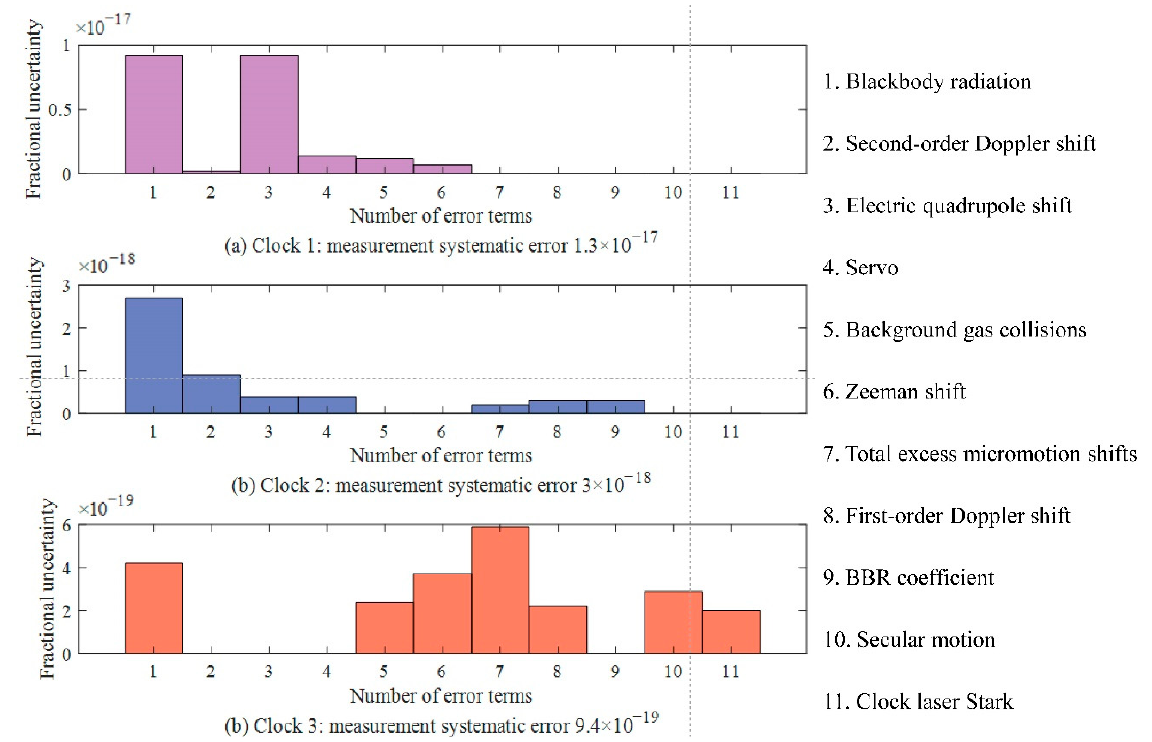
Figure 4. Measurement systematic error items of existing optical clocks. Table 1. Measurement systematic error items of existing and potential optical clocks.